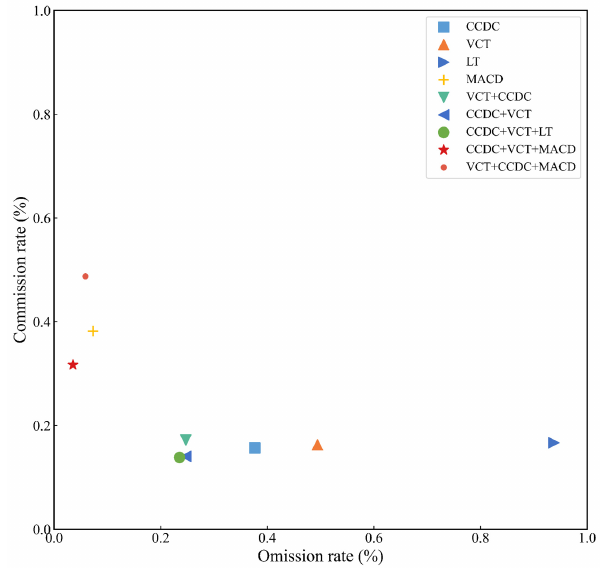
Figure 3. Performances of the algorithms and ensemble models. The commission rate and omission rate are lower at points closer to (0,0).